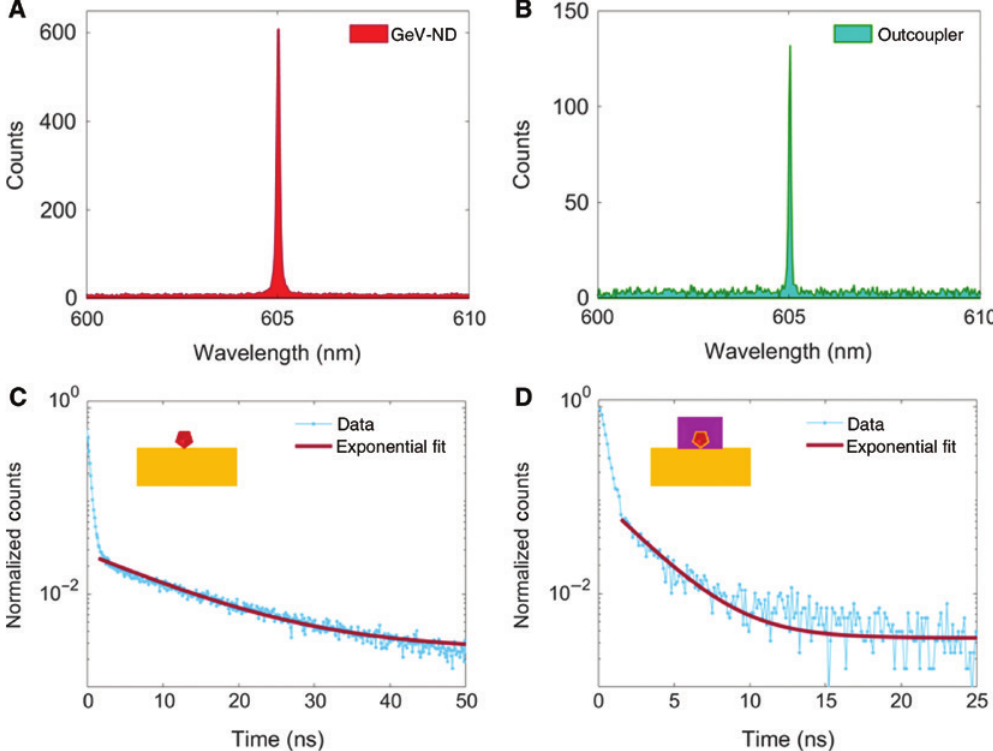
Figure 4: Characterization of a GeV-ND coupled to the unidirectional SPP waveguide device. (A, B) Spectra taken from the embedded GeV-ND (A) and from the outcoupled light at the end (B). (C, D) Lifetime measurement data from uncoupled GeV (C; ND on gold crystal), and coupled GeV (D; ND embedded in the device). The data were analyzed with a single exponential = A · exp( − t / τ function [ I ) + C , where τ indicates the lifetime, and A and C are constants] [16, 30], indicating a 5-fold lifetime shortening tot A A from 11.2 ns (ND on gold flake) to 2.3 ns (ND embedded in device). Considering an additional 2-fold reduction due to the metal layer [30], we estimated a 10-fold decay rate enhancement in total (see Supplementary Section